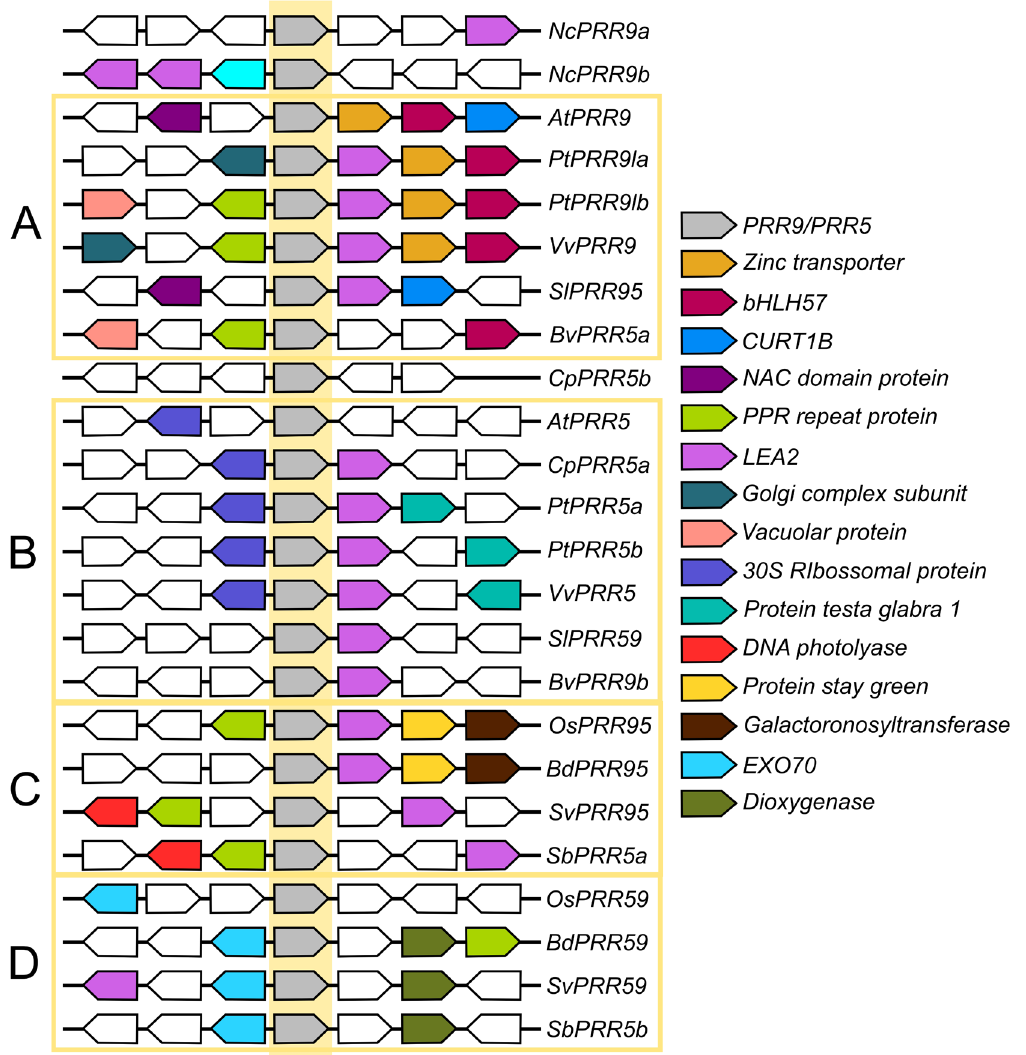
Figure 4 - Positional orthology of members of the PRR9/5 clade. The flanking genes of the PRR9/5 orthologs (grey polygons in the yellow centre) of eleven vascular plant clades were identified and colour-coded according to their identity—the polygons point toward the annotated direction of the gene. Four groups of orthologs can be identified through similarities: two for eudicots (A and B) and two for monocots (C and D) . Sequences ID can be found in Table